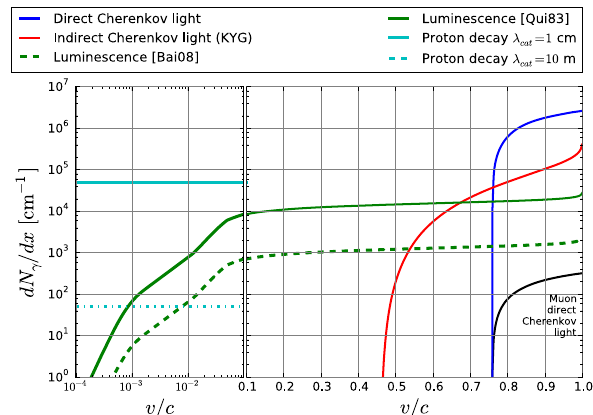
Fig. 35 Light yield for the different radiation mechanisms of magnetic monopoles [329]. For comparison the direct Cherenkov light emitted by a minimum ionising muon is